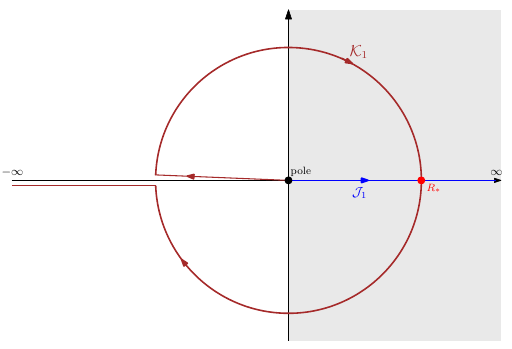
Figure 7 . For repulsive interaction, J 1 is the steepest descent cycle. The critical point moves to infinity as the regulator is removed. J extends from the pole to + ∞ . 1